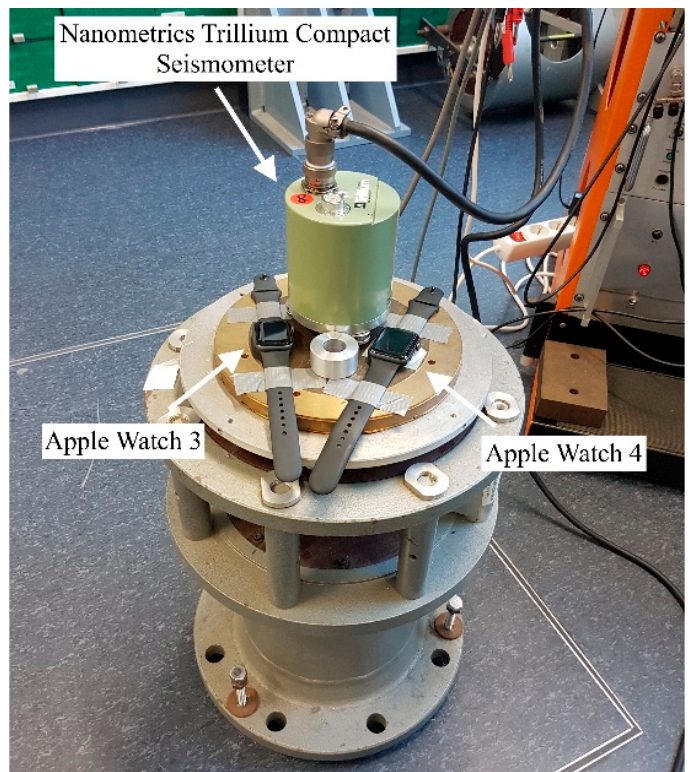
Figure 2. Experimental setup of the sensor validation experiment. Apple Watches Series 3 and 4 and a Nanometrics Trillium Compact seismometer were placed on a vertical vibration table. The table simultaneously accelerated the devices by oscillatory motions with tremor-typical frequencies and amplitudes. Both watches were connected to Apple iPhones (not in this figure) via Bluetooth, where the measurement data were stored. The seismometer data were collected on a digitizer (not in this figure) that the device was connected to.